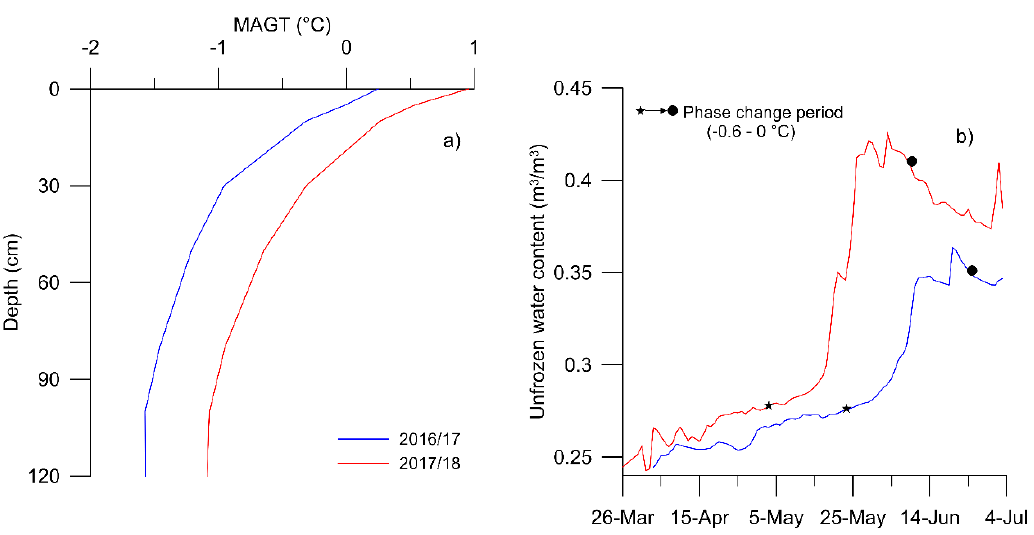
Figure 6. Changes in mean annual ground temperature (MAGT) between the hydrological years 2016–2017 and 2017–2018 ( a ) and water content in frozen soil during the phase change periods in 2017 and 2018 after snowmelt at the UBF site ( b ).